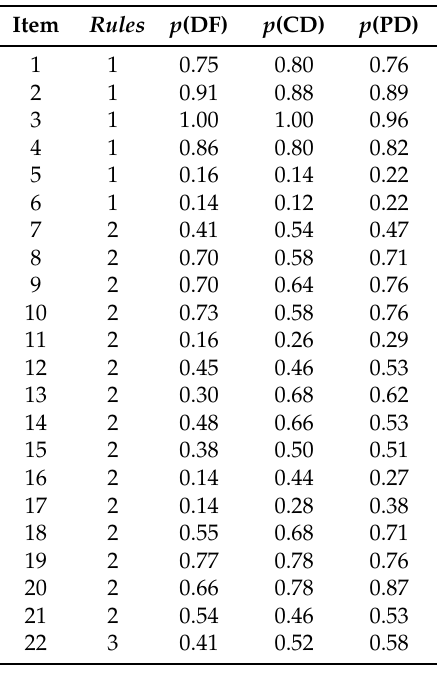
Table 1. Item difficulties using the distractor-free (DF), the conceptual distractor (CD), and the perceptual distractor (PD) response